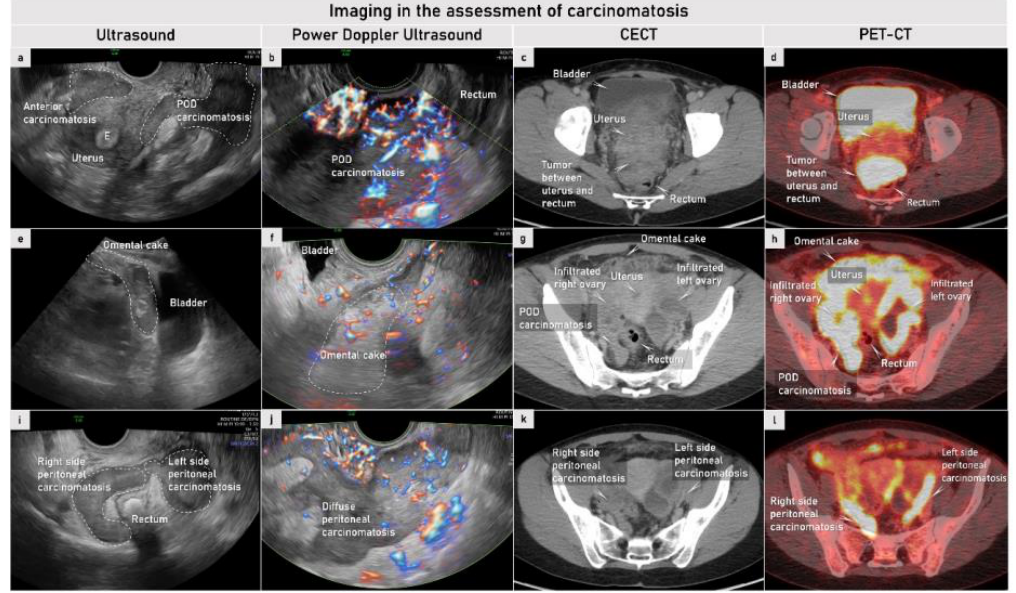
Figure 9. Advanced high-grade serous tubal cancer FIGO stage IVB. Sagittal plane of transvaginal ultrasound image demonstrating hypoechogenic diffuse carcinomatosis infiltrating the anterior and posterior compartments ( a ); carcinomatosis is highly perfused on Power Doppler ultrasound ( b ); axial (transverse) plane in CECT showing peritoneal carcinomatosis as a solid enhanced tumour between uterus and rectum and PET/CT demonstrating FDG avid peritoneal carcinomatosis tissue ( c , d ). Diffuse infiltration of infracolic omentum (omental non-homogenous cake) demonstrated on sagittal plane on gray-scale transabdominal scan with moderate perfusion detected by Power Doppler on transvaginal ultrasound ( e , f ); corresponding images from axial (transverse) plane in CECT (increased density in the omental fatty tissue) and PET/CT (FDG avid infiltration of omentum) ( g , h ). Diffuse hypoechogenic pelvic carcinomatosis on pelvic side walls in transverse plane in gray-scale transvaginal scan with moderate perfusion demonstrated with Power Doppler ( i , j ), and with corresponding images from CECT (thickening and enhancement of peritoneal reflection) and PET/CT (FDG avid peritoneal carcinomatosis tissue) in axial (transverse) plane ( k , l ). CECT, contrast-enhanced computed tomography; E, secretory endometrium; FIGO, International Federation of Gynecology and Obstetrics; PET/CT, positron emission tomography/computed tomography; FDG, fluorodeoxyglucose; POD, pouch of Douglas. Figure 10. High-grade serous tubal cancer FIGO stage IVB. Axial CECT and PET-CT scans of the same patient as presented in Figure 9 are demonstrating the left paracolic peritoneal carcinomatosis implant (marked with arrows) and polycystic kidneys bilaterally (stars) ( a , d ); the carcinomatosis has high metabolic activity on PET/CT, within the renal calyces the excretion of FDG is visible ( d ). The liver shows multiple cysts (marked with a star; the arrow points to a nodule of visceral carcinomatosis on the liver surface with metabolic activity in the PET-CT; however, it is barely